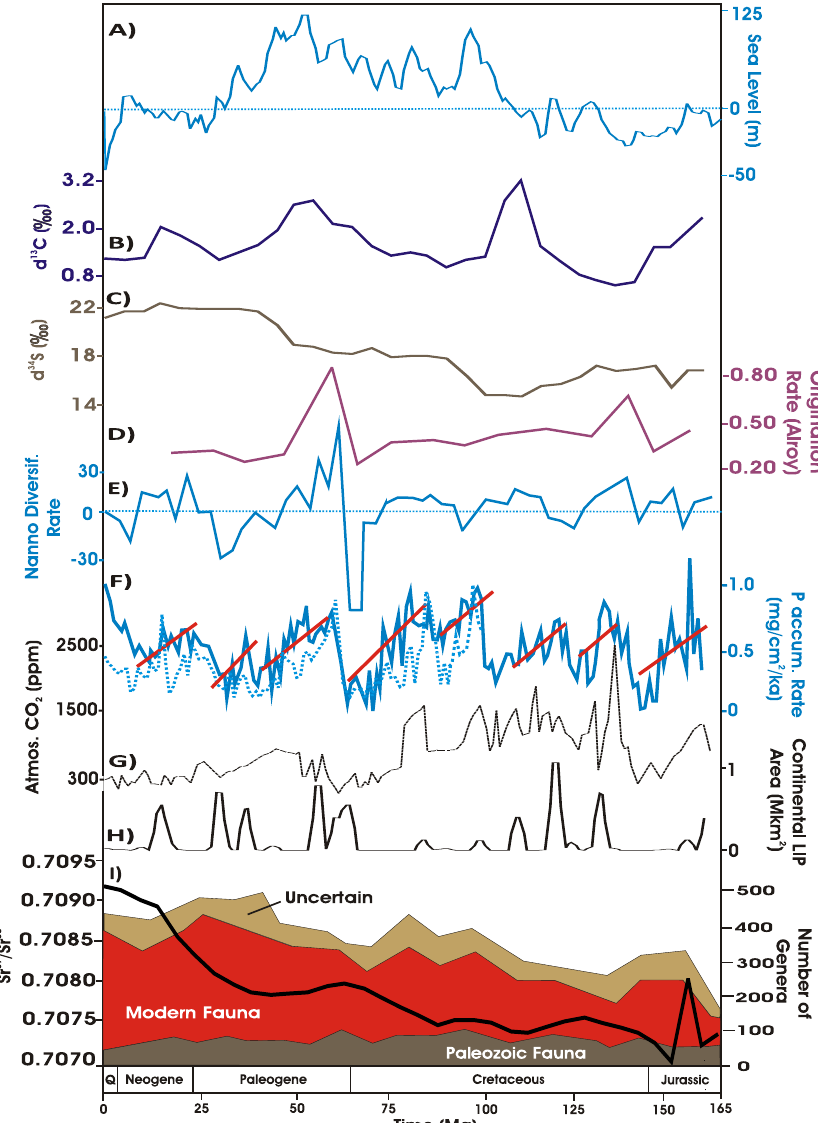
Figure 2. Physical, biogeochemical, and diversity indices for the Phanerozoic. ( A ) Sea level 47 . ( B ), δ 13 C 12 . ( C ) δ 34 S 12 . ( D ) Origination rate 12 . ( E ) Nannofossil diversification rate 41 . ( F ) Phosphorus accumulation rates (PAR) 43 . Solid line: total (biogenic + detrital) rate. Dashed line: biogenic rate only. Solid lines indicate generally declines in PAR and CO 2 following Large Igneous Province (LIP) emplacement. Original PAR outlier value at 0.5 Ma removed for sake of scale (see Supplementary Figures and Tables). ( G ) Carbon dioxide levels 41 . ( H ), Area of continental Large Igneous Province (LIP) emplacement 34 . ( I ) Meso-Cenozoic genera biodiversity from Fig. 1 and strontium isotope ratios in approximate 5-myr bins 12